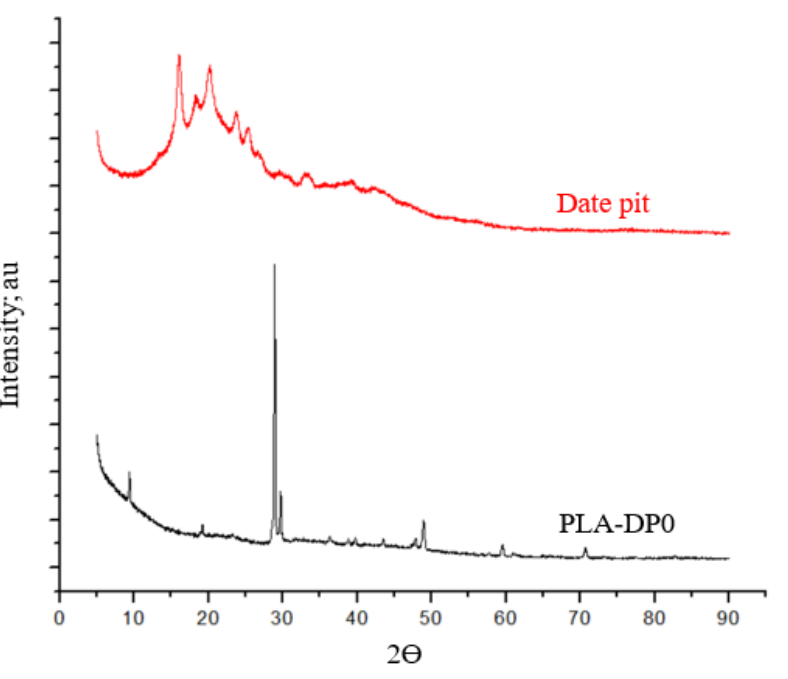
Figure 5. X-ray diffraction (XRD) traces of pure PLA and date pit powder.